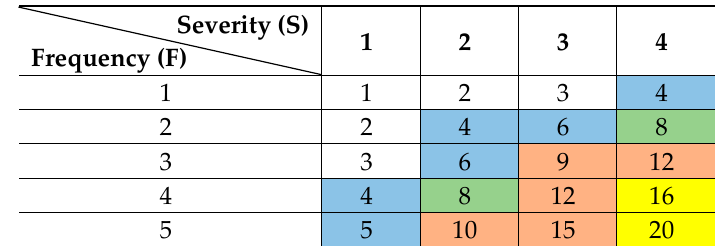
Table 2. Risk ratings in Korea.